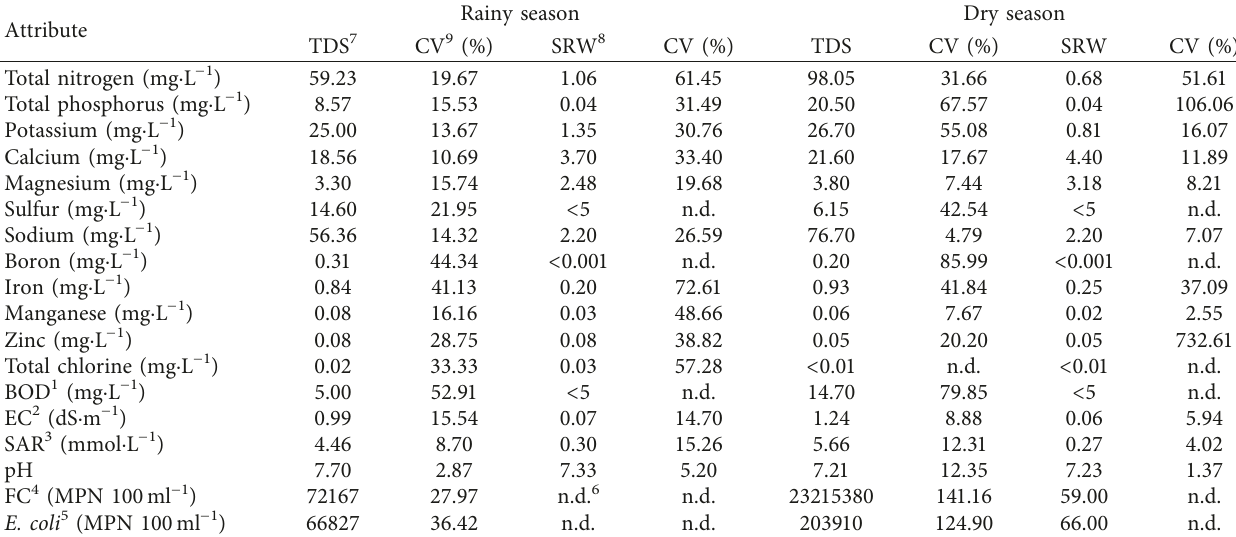
Table 3: Average concentration of the water quality parameters used in irrigation during the rainy and dry periods for the first crop.